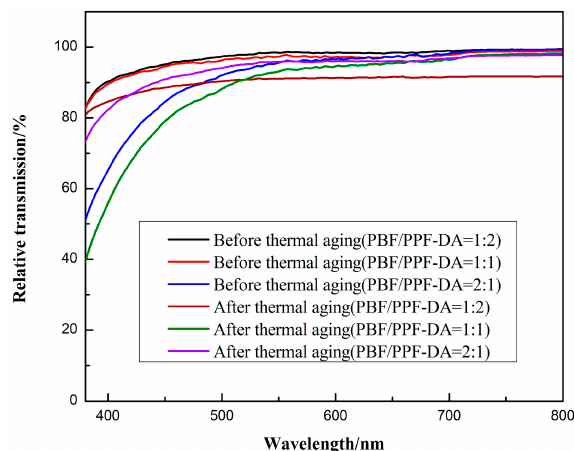
Figure 6. Transmittance of the prepared encapsulation material before and after thermal aging (one week).